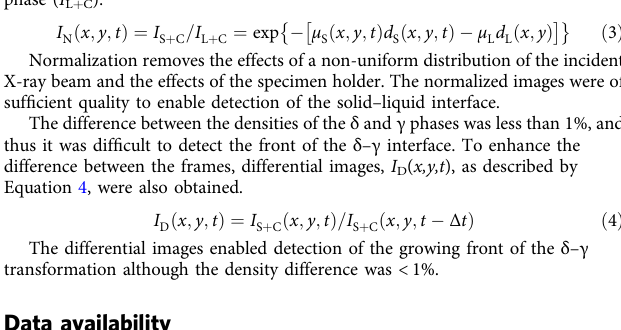
Fig. 5 Setup for time-resolved and in situ observations. a Four-jaw slit to de fi ne the incident beam size. b Absorber (a SiO 2 glass plate) to adjust the intensity of the X-ray beam. c Ion chamber to measure the intensity of the X-ray beam that irradiates a specimen. d Stages to control furnace position. e Specimen and furnace that consist of a graphite heater and BN frames. The specimen is heated under a vacuum chamber. f Stages to control specimen position. g X-ray beam monitor to observe X-ray transmission images. Red line indicates an X-ray beam (20 or 21